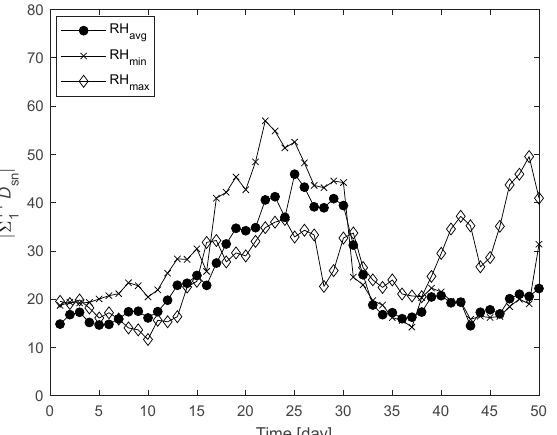
Figure 6. Variation of the classification potential ( D sn values) when using the daily minimum, maximum and average values of relative humidity. Day 1 is the beginning of the growing season.